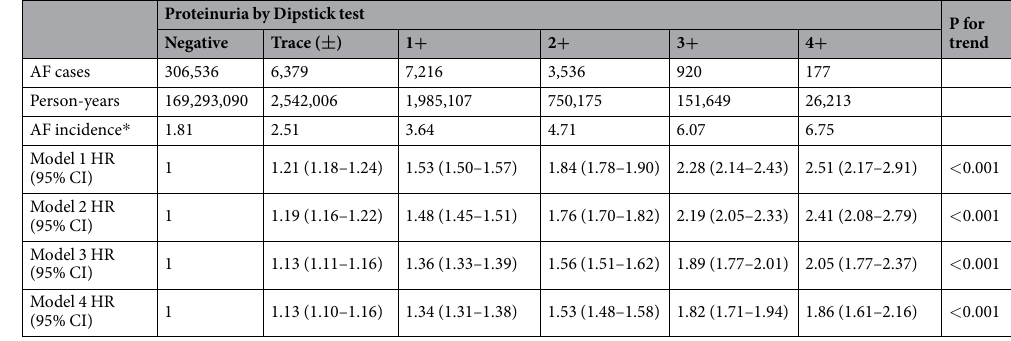
Table 3. Incidence and risk of atrial fibrillation according to the degree of proteinuria by dipstick test adjusted for other covariates in the Main Cohort (between 2005 and 2008). AF, atrial fibrillation; CI, confidence intervals; HR, hazard ratios * Per 1000 person-years Model 1: Cox proportional model adjusted for age and sex. Model 2: model 1 with additional adjustment for body mass index, smoking, alcohol consumption, and exercise frequency. Model 3: model 2 with additional adjustment for diabetes, hypertension, dyslipidemia. Model 4: model 3 with additional adjustment for ischemic heart disease, congestive heart failure, stroke, and chronic obstructive pulmonary